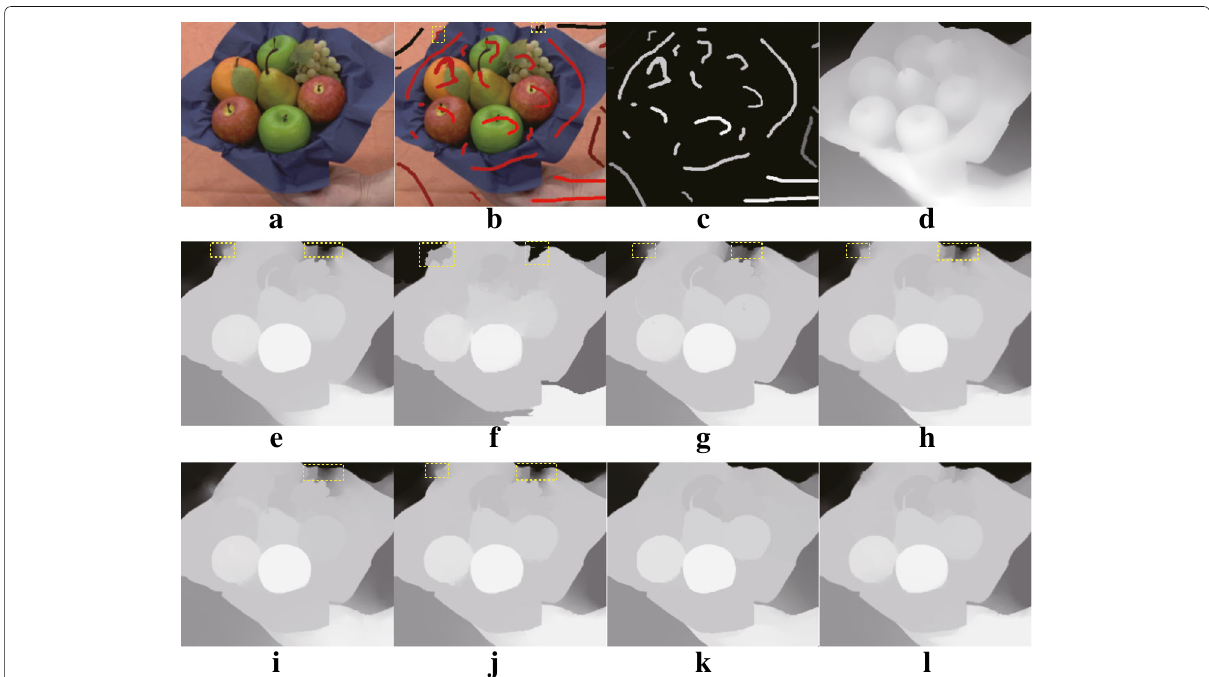
Fig. 10 Results of RGBZ_07 with cross-boundary input. a Input image. b User-labeled image. c Sparse depth. d Groundtruth depth. e Depth of RW. f Depth of HGR. g Depth of NRW. h Depth of OPT. i Depth of OCP. j Depth of SDF. k Depth of (cid:2) 1 . l Depth of the proposed method. Please zoom in to see details